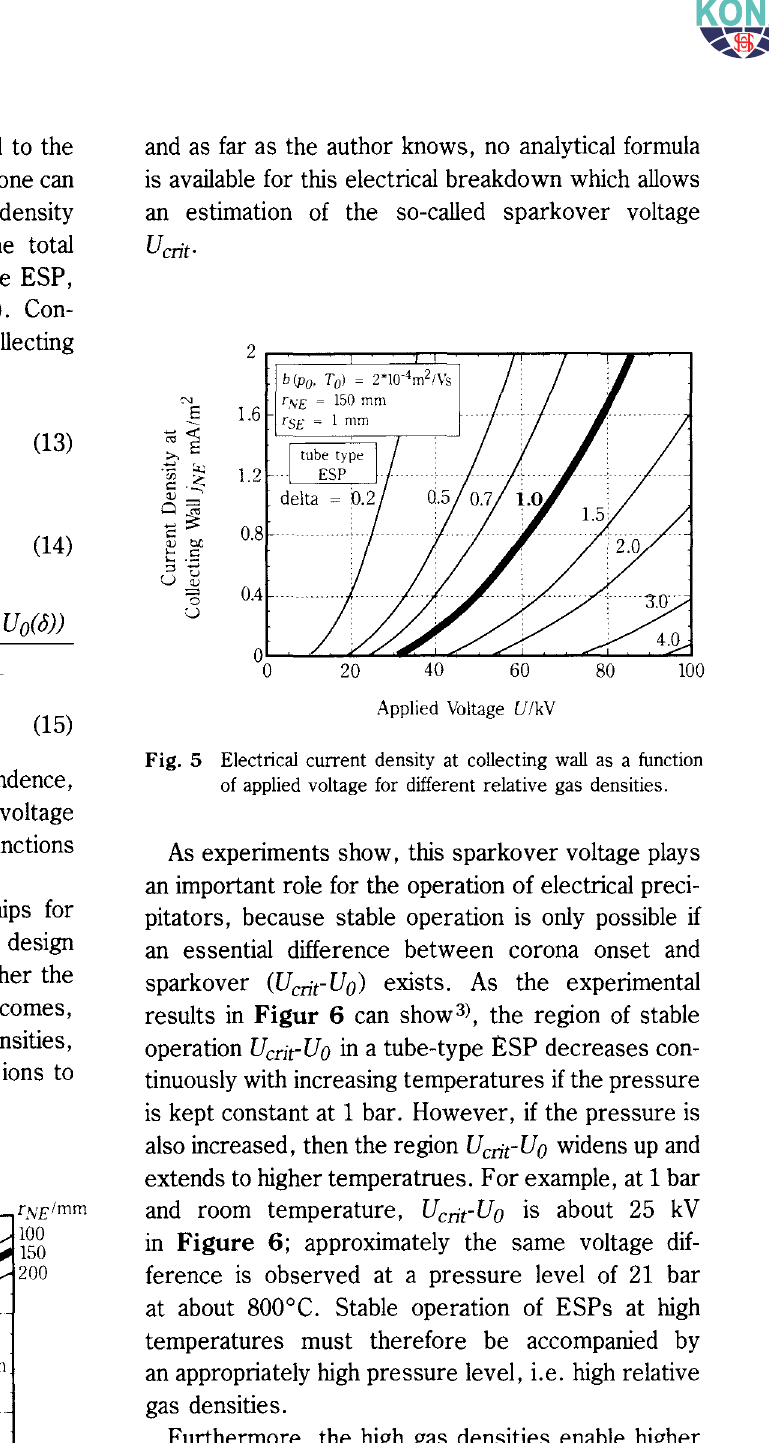
Fig. 4. Corona onset voltage as a function of relative gas density for different tube and wire radii.